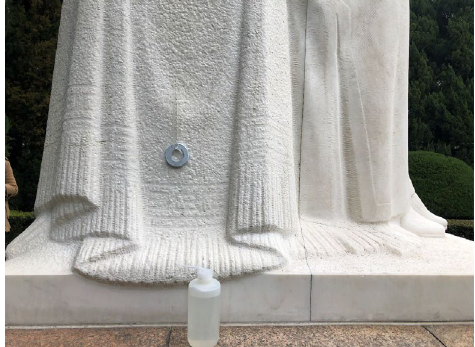
Figure 14 . Water leaks from the sealed marble during water